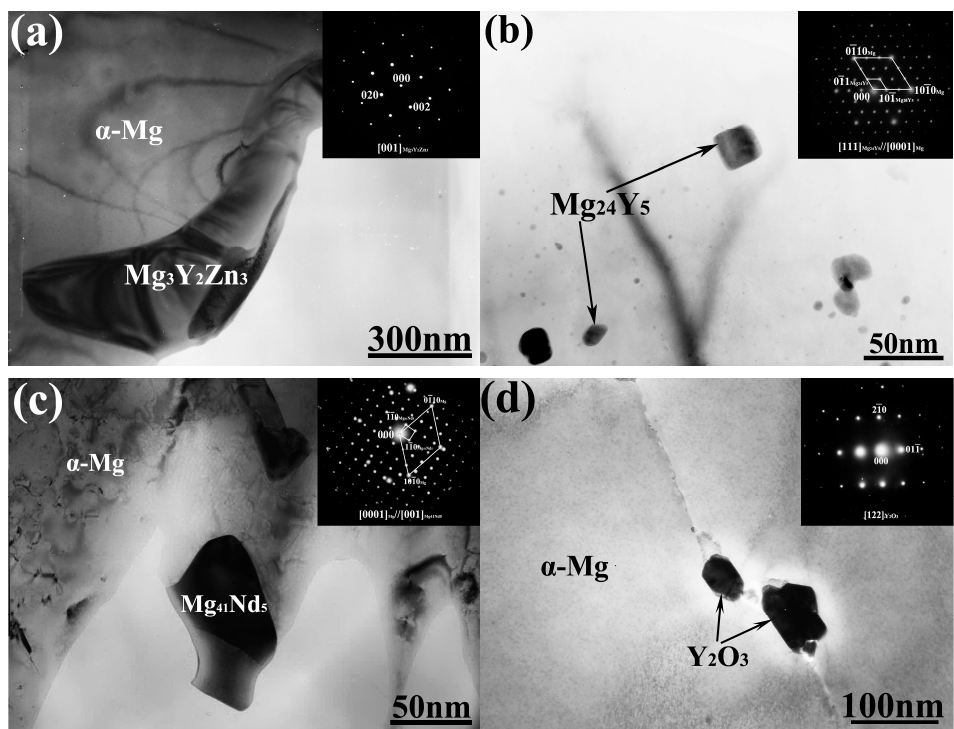
Figure 3. Bright-field TEM micrograph of the precipitates in the Mg–Zn–Y–Nd alloy: ( a ) the Mg 3 Zn 3 Y 2 phase along grain boundary, ( b ) the small Mg 24 Y 5 particles randomly distributed in the matrix, ( c ) the Mg 41 Nd 5 precipitate along the boundary, ( d ) morphology of the Y 2 O 3 particle along the grain boundary (inset micrographs exhibiting the corresponding selected area electron diffraction (SAED) patterns of the phases).